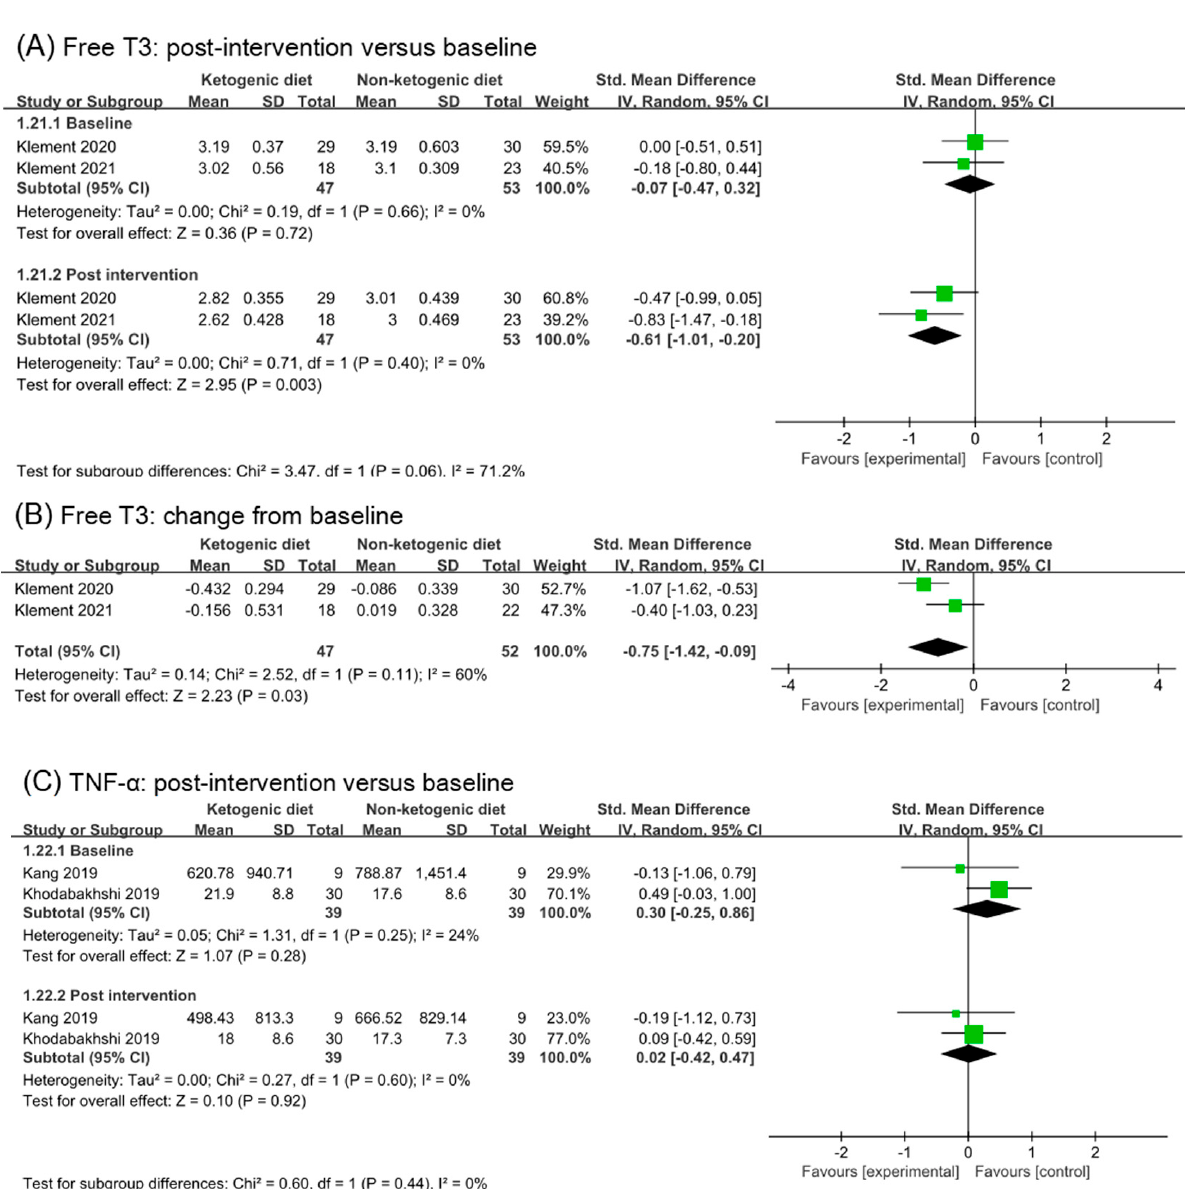
Table 2. Summary of quality of life in studies.